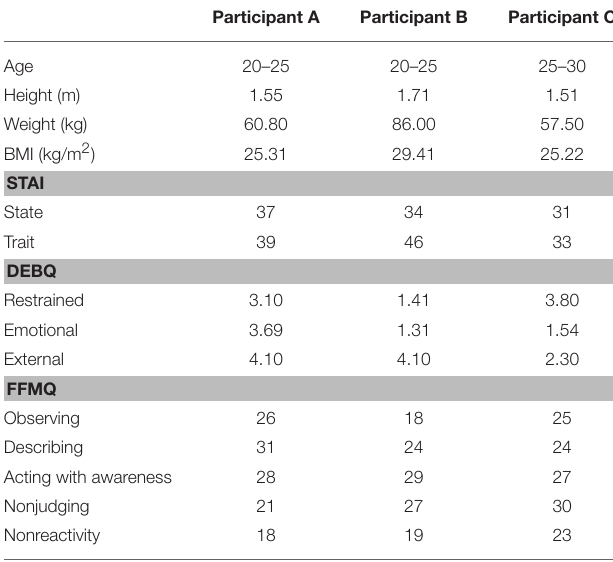
TABLE 1 | Participant